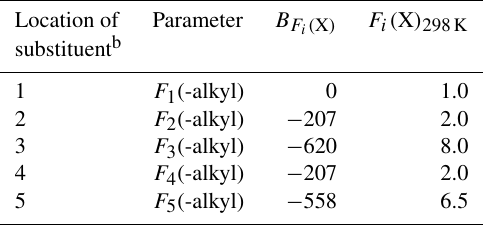
Table 8. Substituent factors F i (X) for the addition of O 2 to aro- matic adducts reactions of OH to aromatic hydrocarbons, and